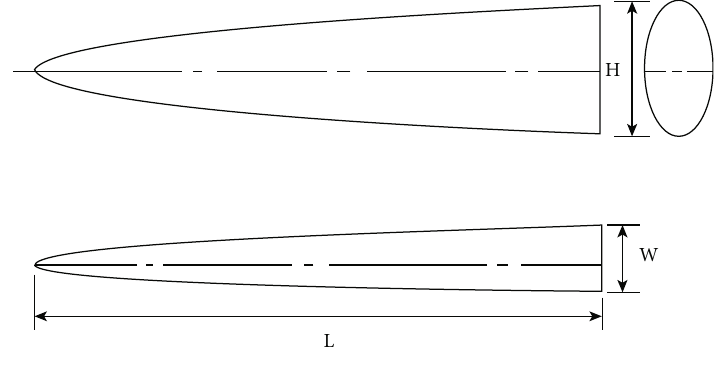
Figure 2: Three views of a noncircular missile forebody.